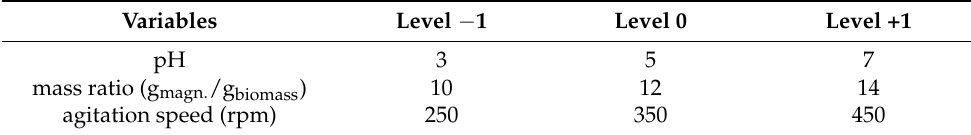
Table 1. Independent variables and the distribution of their level. Variables Level − 1 Level 0 Level +1 pH 3 5 7 mass ratio (g magn. /g biomass ) 10 12 14 agitation speed (rpm) 250 350